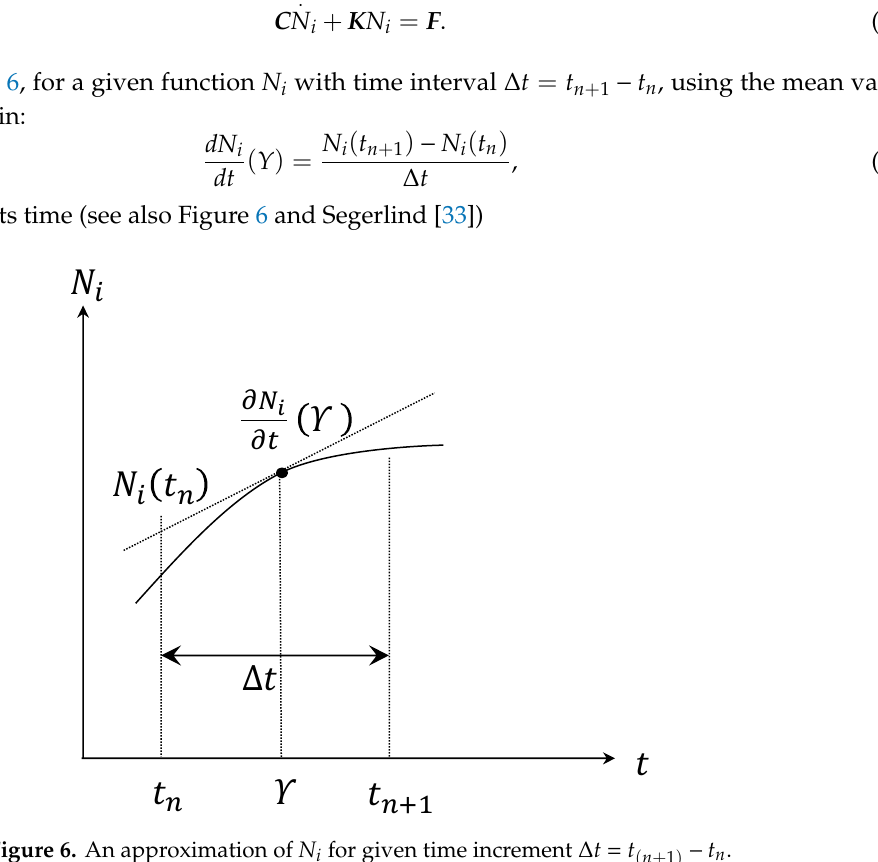
Figure 6. An approximation of (cid:1840) (cid:3036) for given time increment ∆ t = (cid:1872) ((cid:3041)(cid:2878)(cid:2869)) − (cid:1872) (cid:3041) .